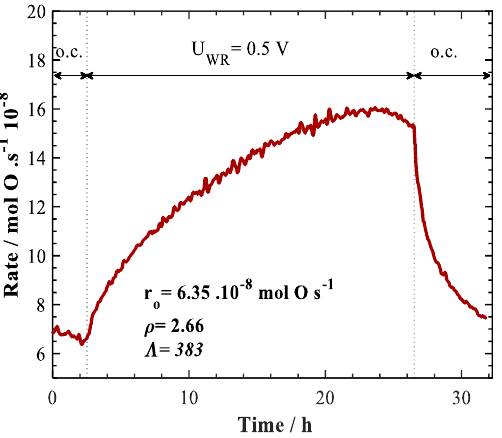
Figure 7. Long period transient rate response of Pd to a potentiostatic step change. o.c.: open-circuit. Conditions: T = 425 °C, 2 kPa of CH 4 and 4 kPa of O 2 . Flow rate: 100 ccm.